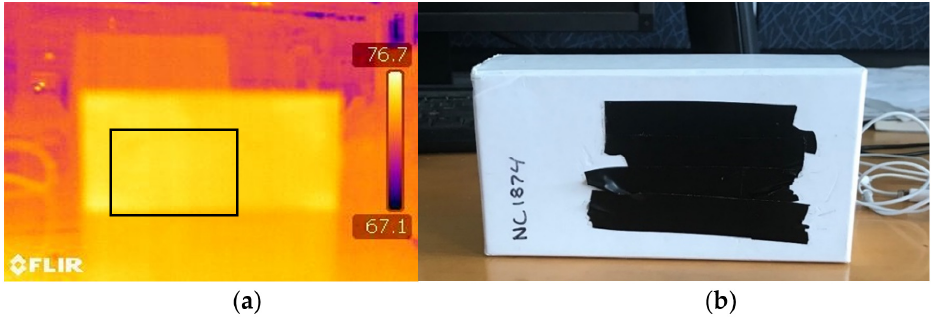
Figure 2. Camera views of the electric tape. ( a ) IR image of electric tape whose color bar ranges between 76.7 °F (23.8 °C) and 67.1 °F (19.5 °C); ( b ) RGB image of electric tape.